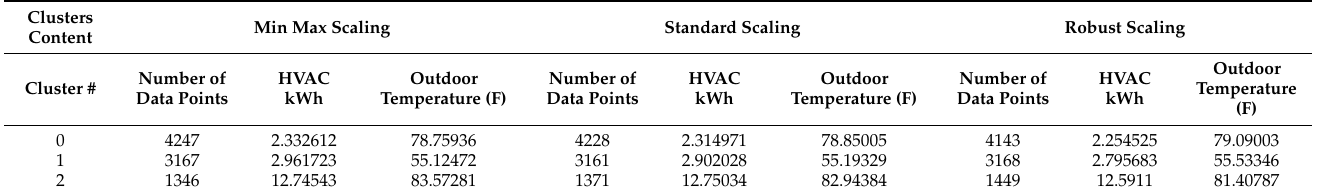
Table 6. Clustering the HVAC consumption and outdoor temperature: results.